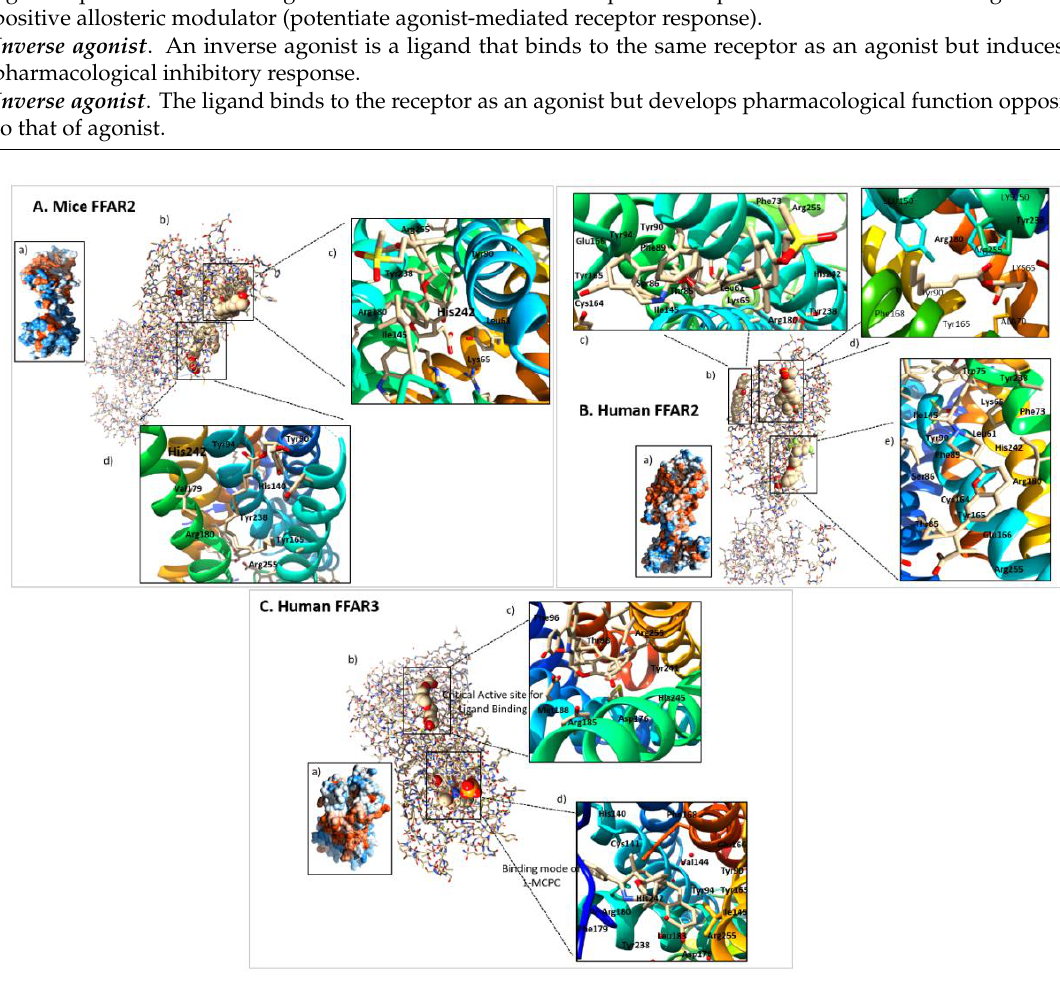
Figure 5. Mice ( A ) and human ( B , C ) FFAR2 ( A , B ) and FFAR3 ( C ) Protein-ligand interaction at orthosteric and allosteric sites. ( A ) Mice FFAR2 protein-ligand interaction (a) Hydrophobic model; (b) Ball and stick model with (c) Orthosteric binding site of C3 (Propionate), (d) Allosteric binding site of Cmp1; ( B ) Human FFAR2 protein-ligand interaction (a) Hydrophobic model, (b) Ball and stick model with (c) Orthosteric binding site of 4-CMTB, (d) Critical binding sites, e) Allosteric binding site of 4- CMTB; and ( C ) Human FFAR3 protein-ligand Interaction (a) Hydrophobic model, (b) Ball and